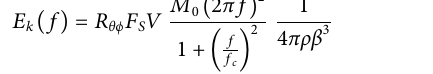
FIGURE 4 Q estimates of the Sichuan Basin (circles) and Songpan- Ganze terrane (triangles) in the frequency range of 0.4 – 20.04 Hz in this study. Results of least-square fi ts to the data are plotted as black solid line for the Sichuan Basin with Q ( f ) (cid:2) 335 f 0 . 72 and gray solid line for the Songpan-Ganze terrane with Q ( f ) (cid:2) 568 f 0 . 338 respectively. The black and gray dotted lines indicate models from Hua et al. (2009) with Q ( f ) (cid:2) 206 . 7 f 0 . 836 and Q ( f ) (cid:2) 274 . 6 f 0 . 423 for the Sichuan Basin and Songpan-Ganze terrane respectively.TheblackandgraydashedlinesshowmodelsfromFu et al. (2019) with Q ( f ) (cid:2) 147 . 5 f 1 . 13 and Q ( f ) (cid:2) 274 . 6 f 0 . 53 for the basin and terrane respectively.